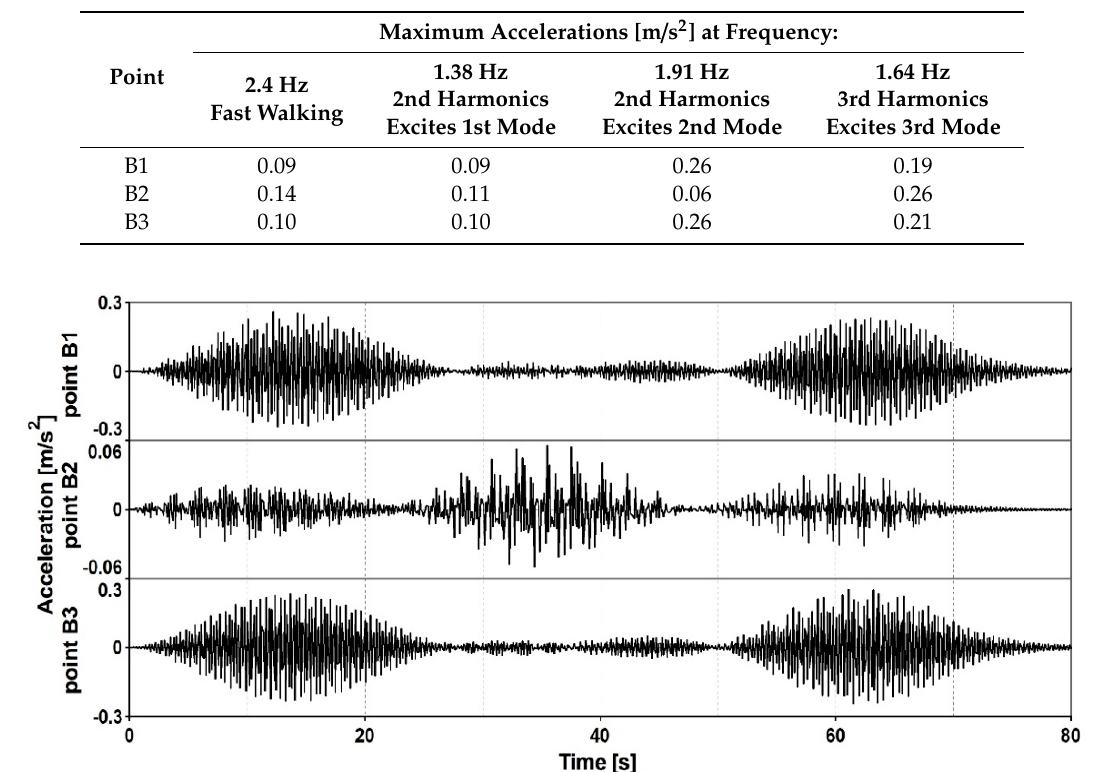
Figure 12. Comparison of time histories of accelerations obtained at the frequency of 1.91 Hz at points B1, B2, and B3.